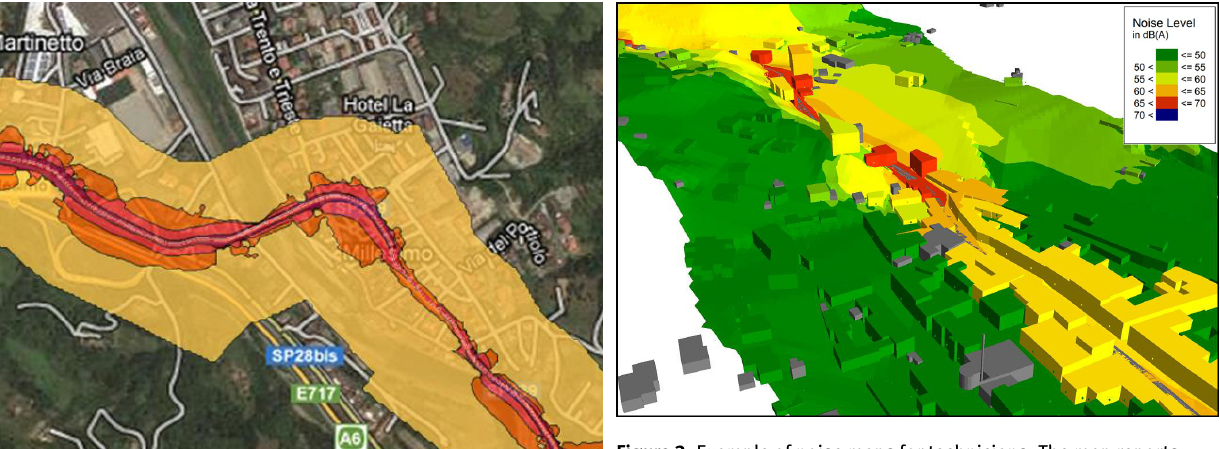
Figure 3: Example of noise maps for technicians. The map reports the isolevel curves of